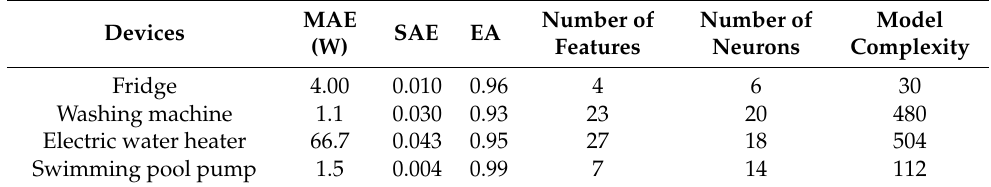
Table 8. Estimation